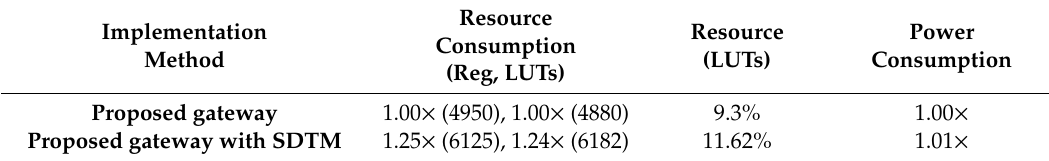
Table 6. Area and power overheads on the Xilinx Zynq-7000 device.